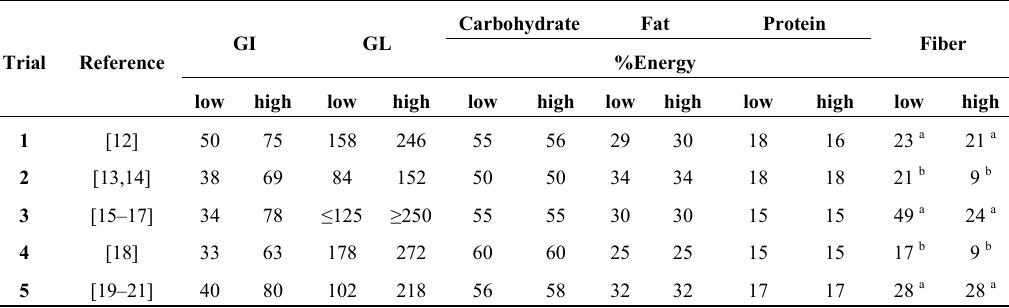
Table 2. Composition of low and high GI/GL diets by